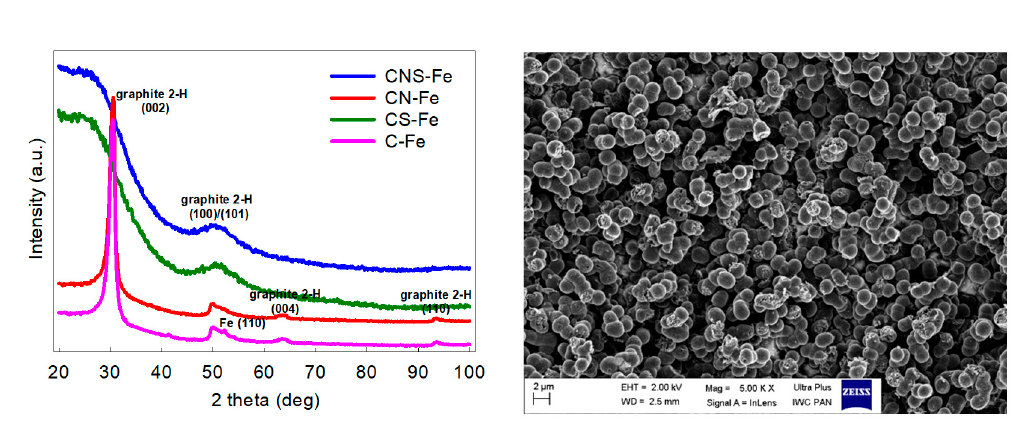
Figure 1. The XRD patterns of the Fe-containing carbon materials. Samples without sulphur underwent significant graphitization (CN-Fe, C-Fe) while sulphur-doped carbons (CS-Fe, CNS-Fe) remained disordered. The representative SEM microphotograph of the studied materials (the Fe- and N-co-doped carbon sample).